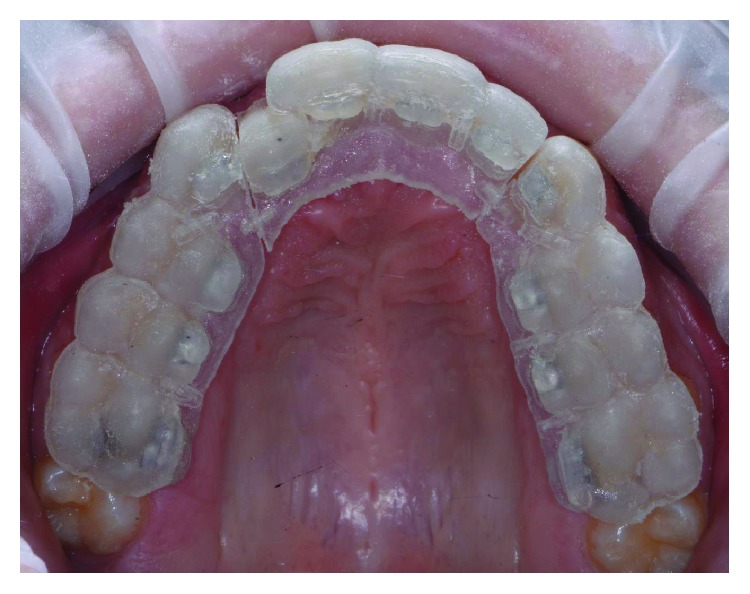
Device placement.